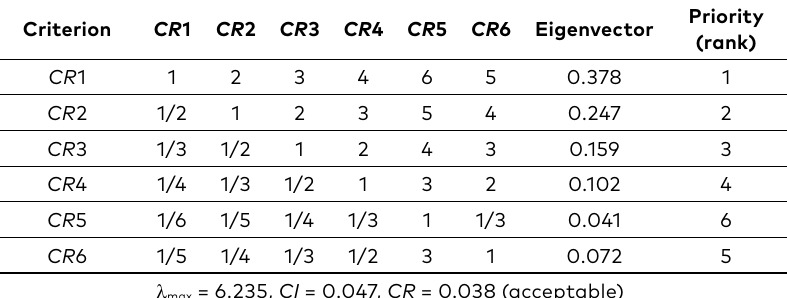
Table 5. Pairwise comparison of criterions